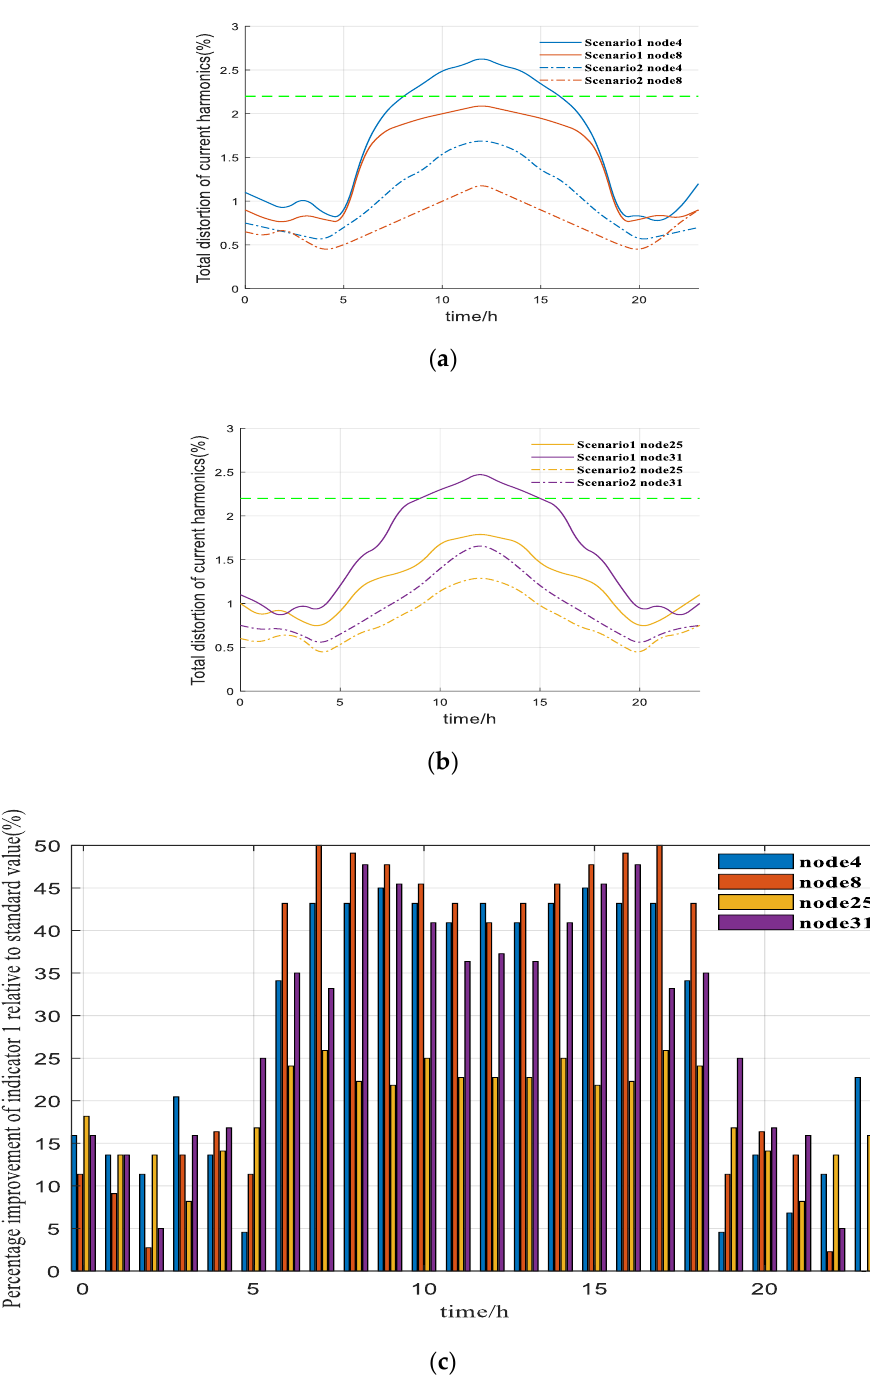
Figure 7. Current harmonic distortion rate curve. ( a ) Comparison of sub-scenarios of nodes 4 and 8. ( b ) Comparison of sub-scenarios of nodes 25 and 31. ( c ) Percentage improvement of current harmonic distortion rate relative to the standard value.